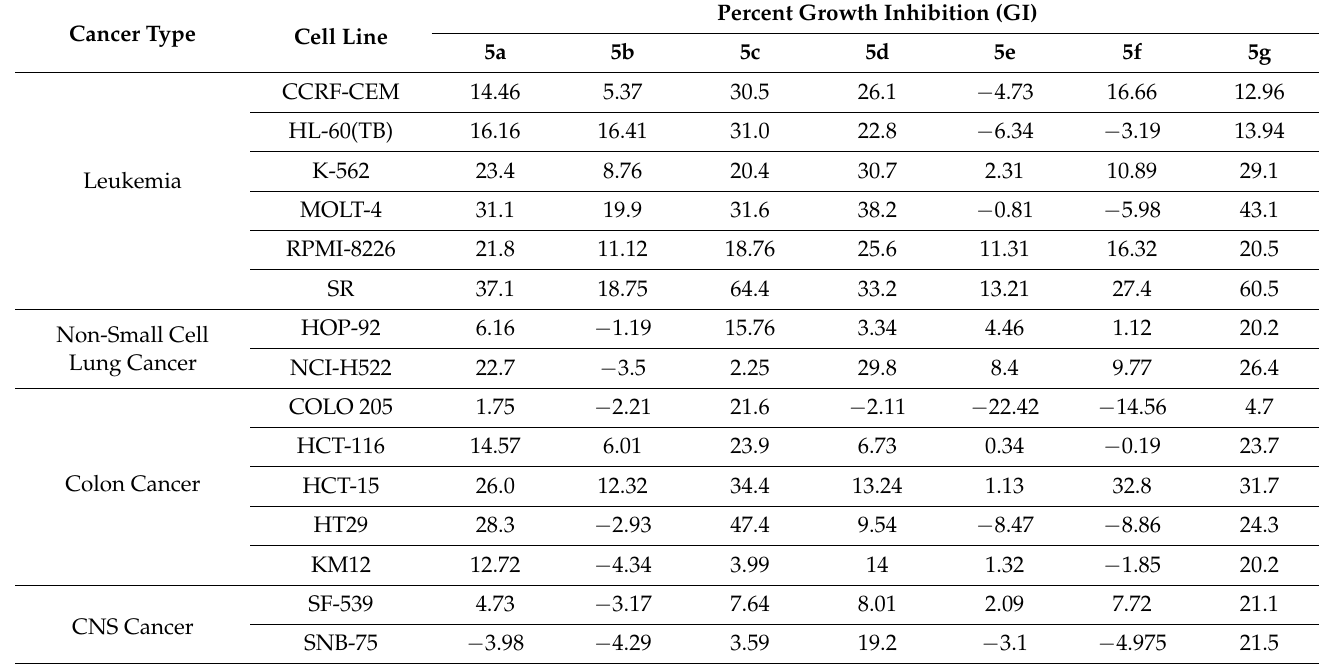
Figure 3. Schematic chart of percent inhibition of all synthesized compounds 5a–5g against a panel of cancer cell lines. Table 4. The growth inhibition percentages of the synthesized compounds over the most sensitive cell lines at a single dose concentration of 10 µM.